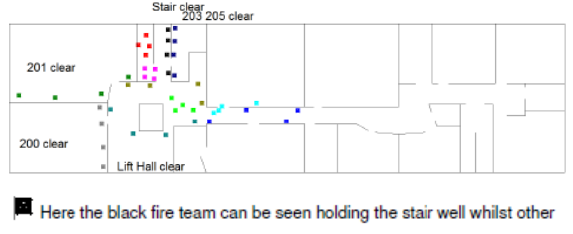
Figure 4. Start of the Operation. Note: each black square—each soldier in first fire team.